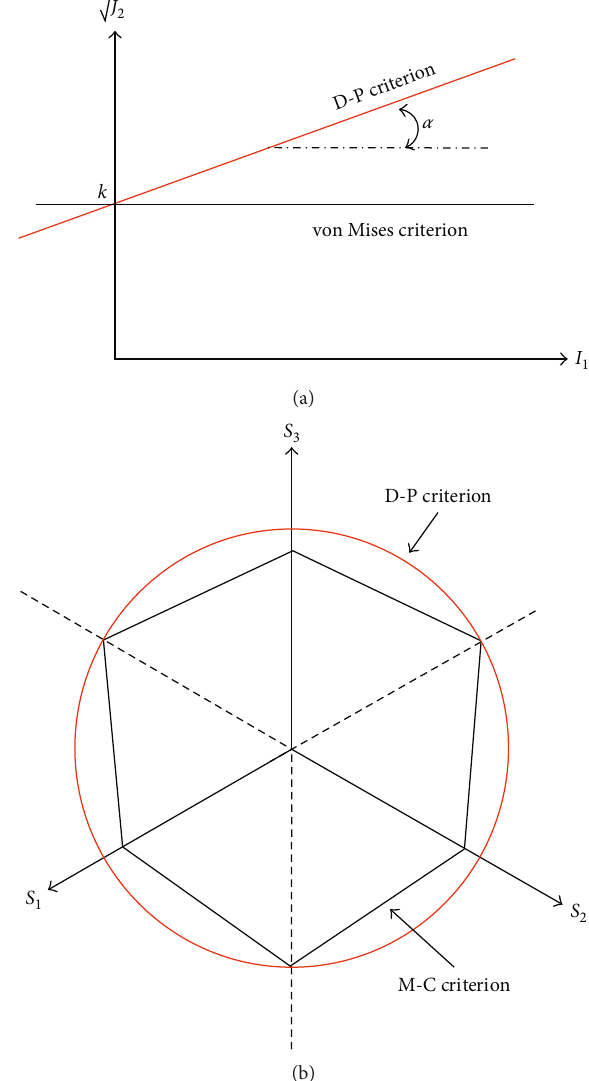
Figure 4: Yield surface for the linear D-P criterion versus V-M criterion and the linear D-P criterion versus M-C criterion: (a) D-P versus Mises criterion in the I criterion in the aπ plane.